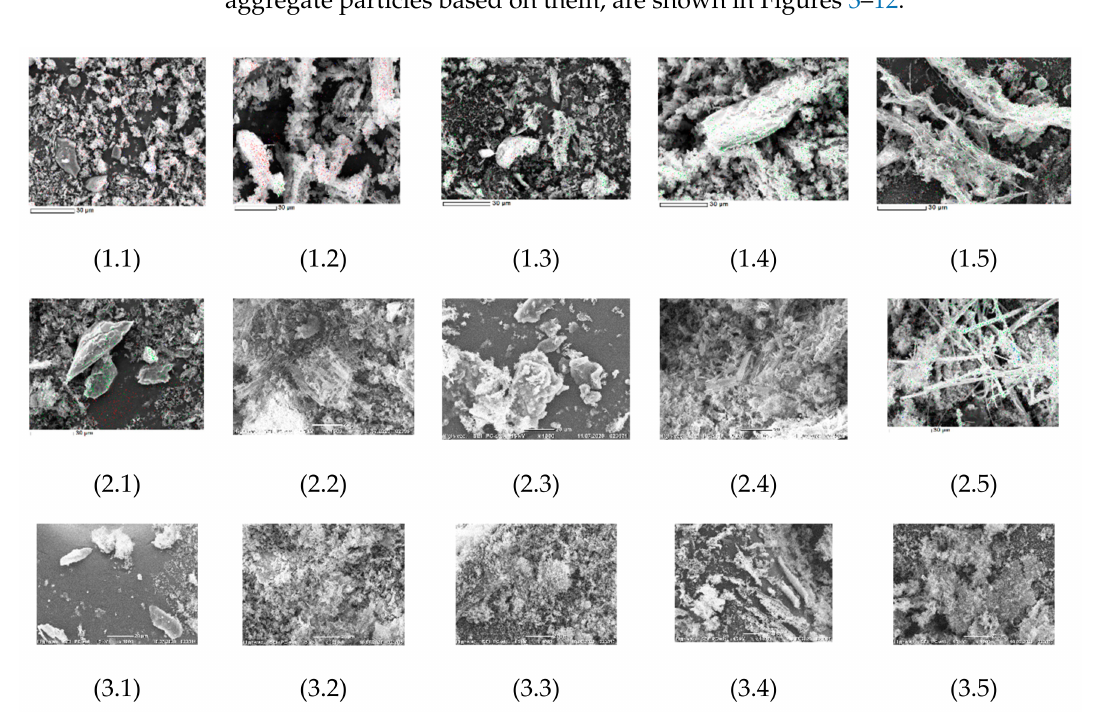
Figure 3. Typical images (of scanning microscopy) of ash after pyrolysis of 3B grade coal particles, wood, and a set of ash particles of fuel mixtures based on them in different component ratios: 1-Ash after pyrolysis at a temperature of 400 ◦ C: 1.1. Coal_100%; 1.2. Coal_90%/Wood_10%; 1.3. Coal_75%/Wood_25%; 1.4. Coal_50%/Wood_50%, 1.5. Wood_100%; 2-Ash after pyrolysis at a temperature of 600 ◦ C: 2.1 Coal_100%; 2.2. Coal_90%/Wood_10%; 2.3. Coal_75%/Wood_25%; 2.4. Coal_50%/Wood_50%, 2.5. Wood_100%; 3-Ash after pyrolysis at a temperature of 800 ◦ C: 3.1 Coal_100%; 3.2. Coal_90%/Wood_10%; 3.3. Coal_75%/Wood_25%; 3.4. Coal_ 50%/Wood_50%, 3.5.